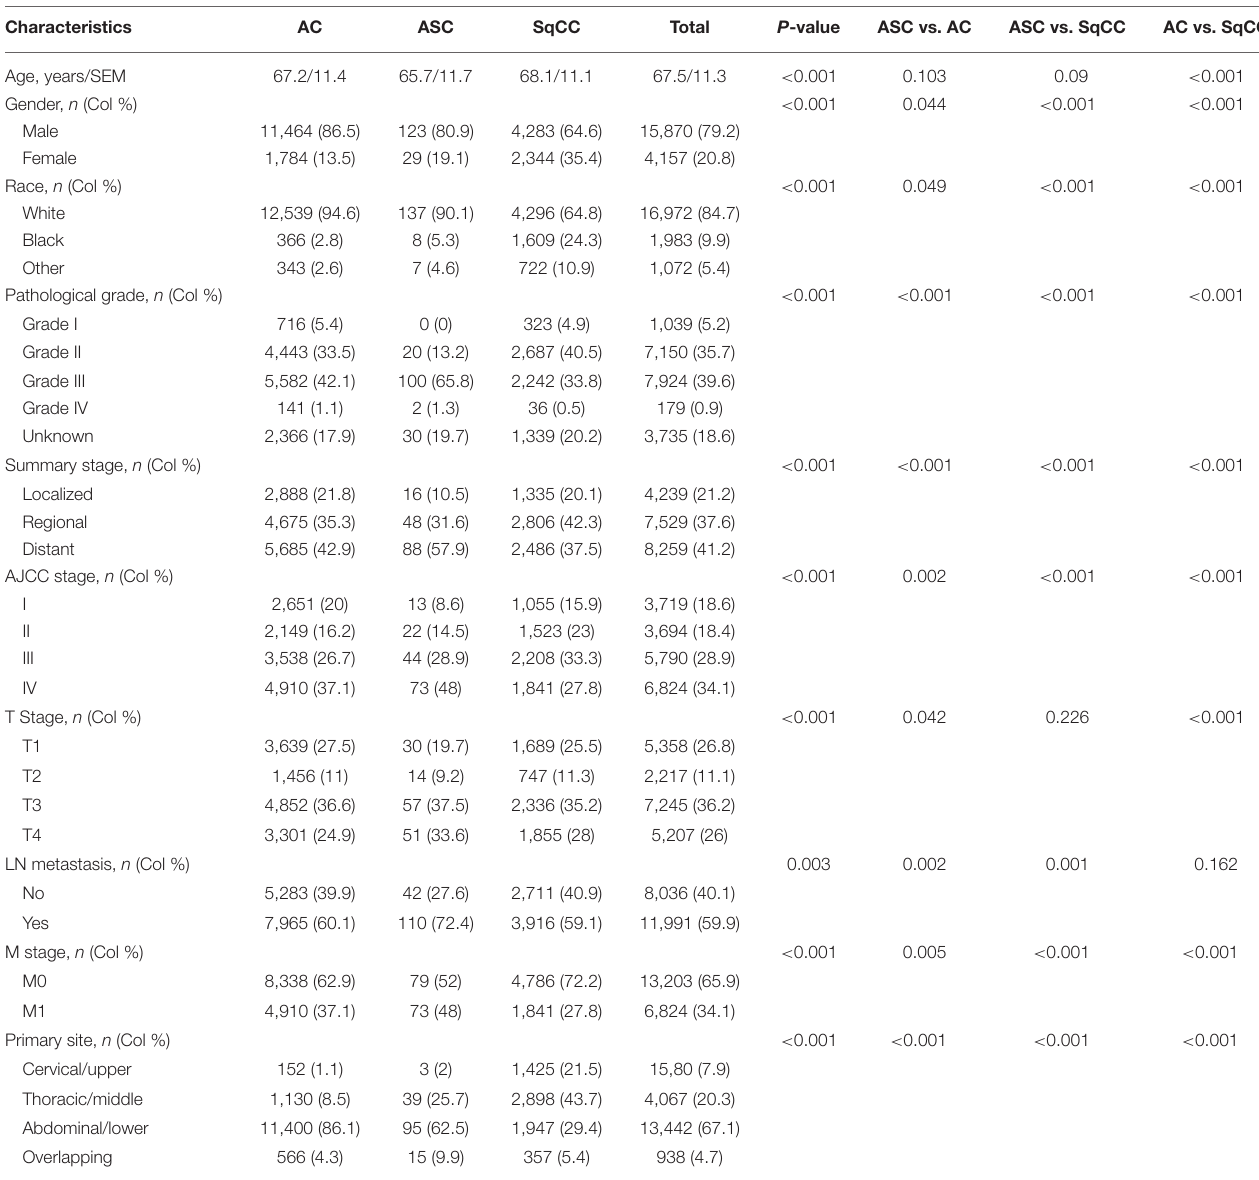
TABLE 1 | Characteristics of patients with esophageal ASC, AC, and SqCC.